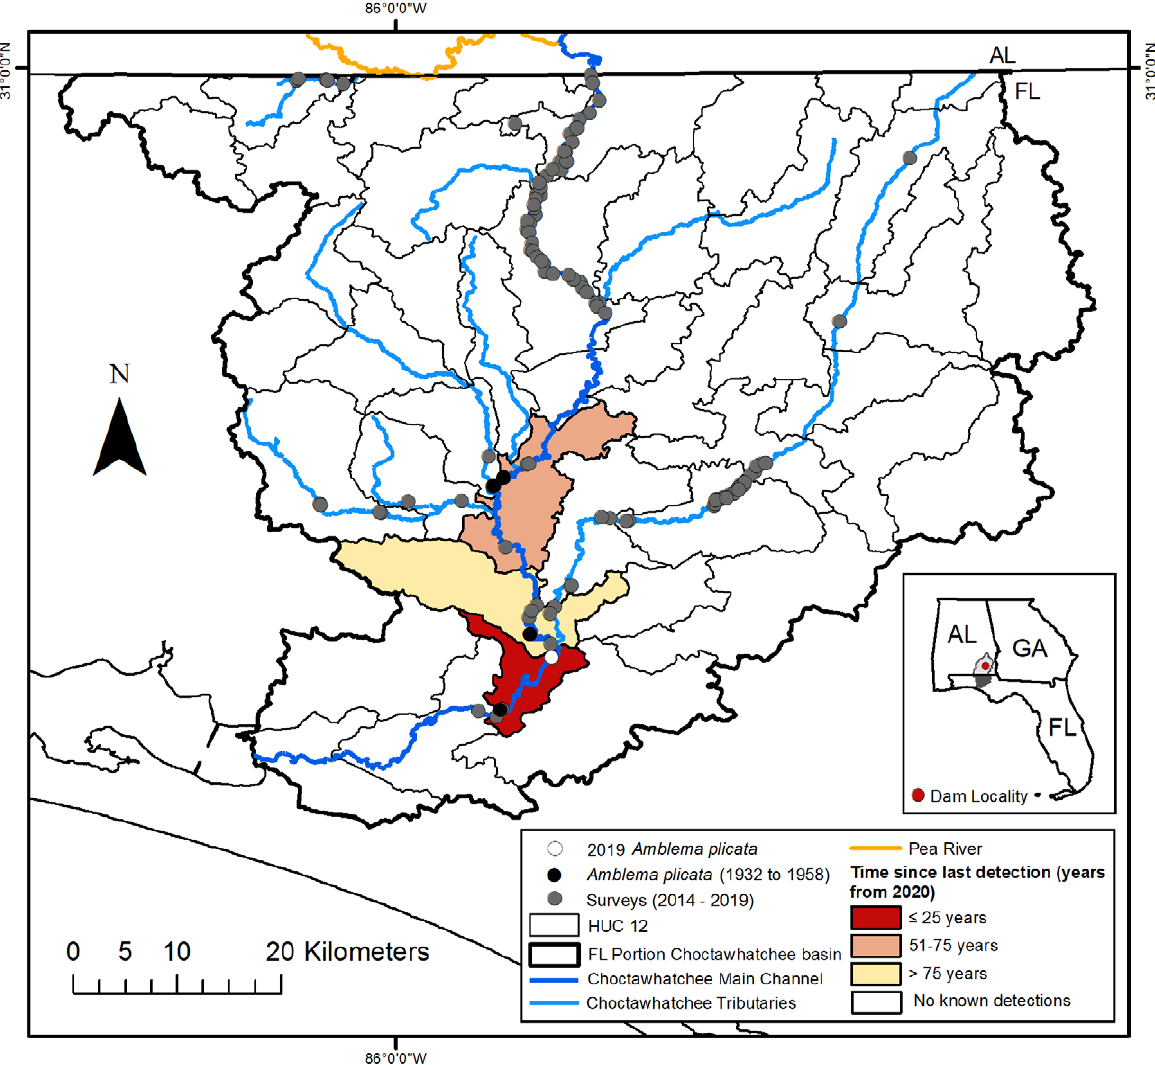
Figure 2. Conservation status map for Amblema plicata . Black or white circles denote presence and grey circles denote absence. Red dot on inset map indicates location of Elba Dam. Hydrological Unit Codes (HUC) 12-level are colored based upon when specimens were collected in that HUC. Map generated with ArcMap v.